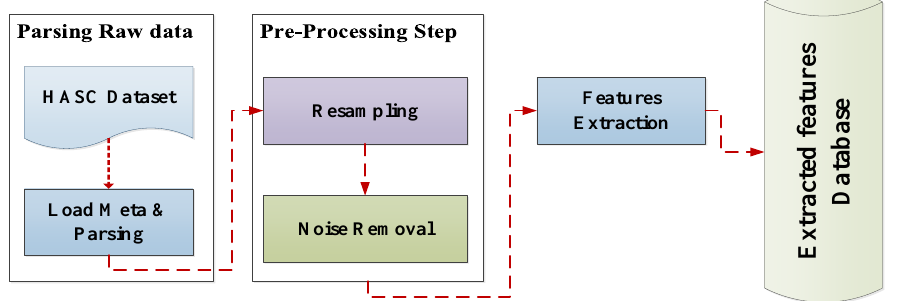
Figure 3. The general overview of data preprocessing.